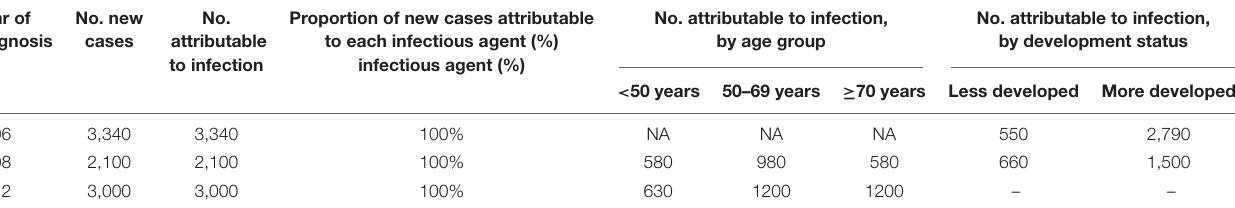
TABLE 3 | ATL incidence in GLOBOCAN.